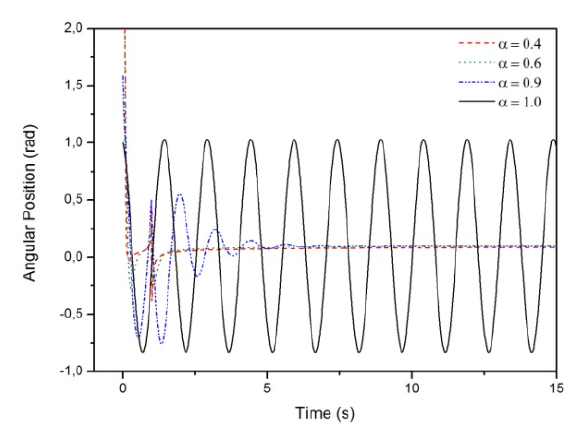
Figure 3. Time history (values of α ≤